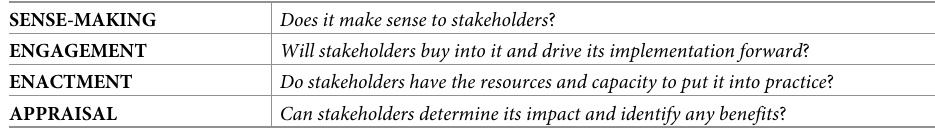
Table 1. NPT constructs to explain what promotes or inhibits implementation.